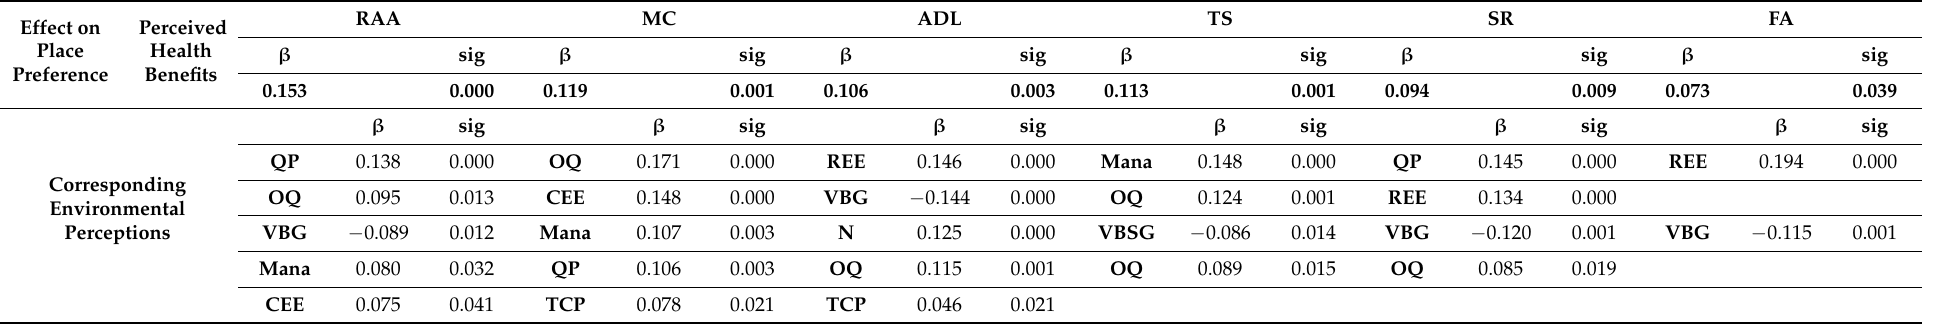
Table 4. The multilevel mapping model results (+, − represent positive and negative correlation,